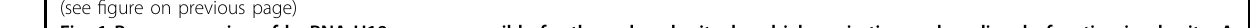
Fig. 1 Poor expression of lncRNA H19 was responsible for the reduced mitochondrial respiration and cardiac dysfunction in obesity. A Seahorse pro fi le for OCRs of the two groups treated with 1.5 μ M oligomycin, 0.5 μ M FCCP, and 1.5 μ M antimycin/rotenone. B , C Western blots of mitochondrial electron transport chain complexes (complexes I – V) in vivo ( n = 6) and in vitro ( n = 3). Results of optical density analyses were presented in Sup. Fig. 1A, B. D RT-qPCR for detection of H19 levels upon treatment with various concentrations of PA in vitro. E , F Western blot analysis of mitochondrial electron transport chain complexes (complexes I – V) following H19 overexpression in vivo ( n = 6) and in vitro ( n = 3). Results of optical density analyses were presented in Sup. Fig. 1C, D. G Seahorse analyses for OCR in H9c2 cells treated by BSA, PA, control lentivirus (vector + PA), and H19 lentivirus (H19 + PA). H and I Echocardiography assessments of E/A ratio and LVDd values in the different treatment groups of Lep − / − mice, n = 7 per group; Data in A – I are expressed as mean ± SEM. * P < 0.05; ** P < 0.01; *** P < 0.001. OCR, oxygen consumption rate; BSA, bovine serum albumin; PA, palmitic acid; CI-CV, mitochondrial respiratory chain complex I – V; Lep − / − , B6-OB mice with leptin defects; WT, littermate control of Lep − / − ; AAV, adeno-associated virus; RT-qPCR, quantitative reverse transcription polymerase chain reaction; LVDd, left ventricular end-diastolic dimension; ATP,